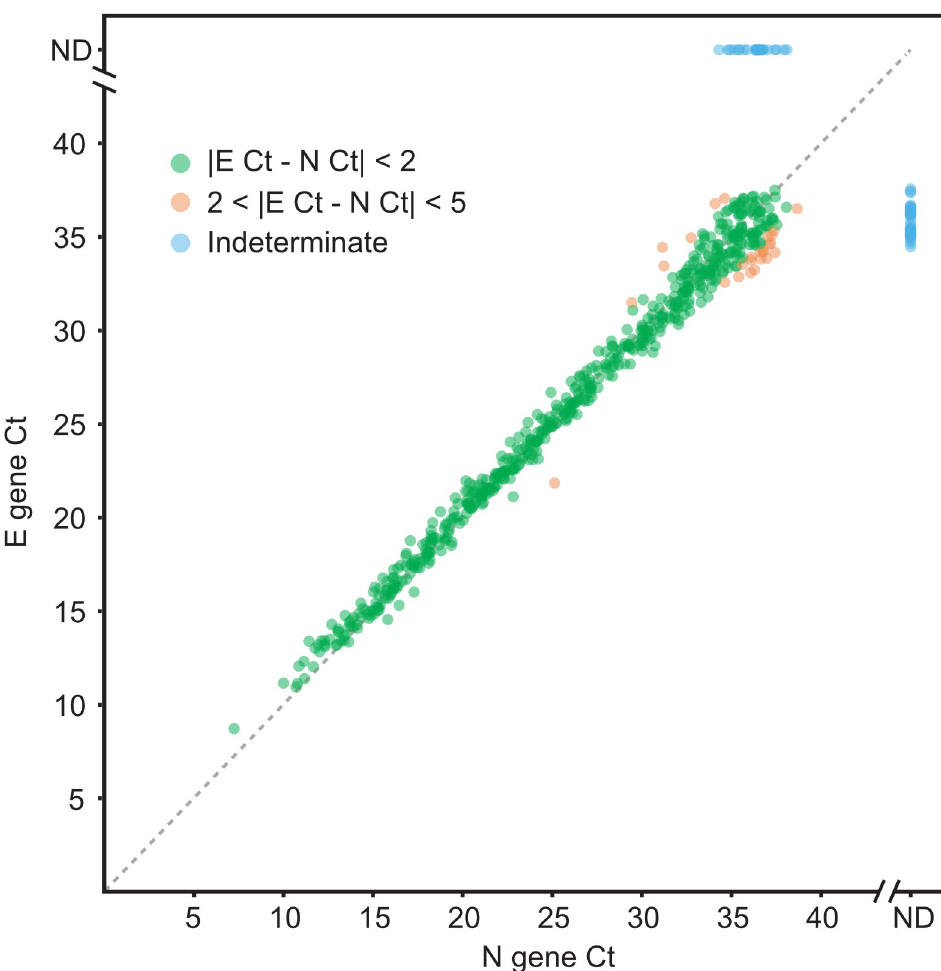
Fig 2. Concordance between RT-PCR Ct values for the E and N gene probes. For 91% of samples, agreement between viral gene probe sets were within 5 Ct cycles, with the majority within 2 cycles. For 9% of samples, only 1 gene was detected (5% E gene only, 4% N gene only), leading to an indeterminate result. In all such cases, the sample extraction and RT-PCR was repeated; points plotted represent the retest result. Ct, cycle threshold; ND not detected; RT-PCR, reverse transcription polymerase chain